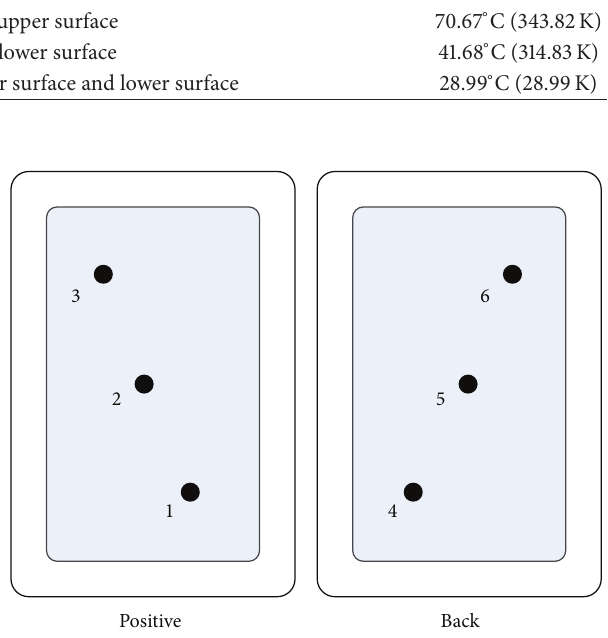
Figure 5: Schematic diagram of test specimen surface TMPs